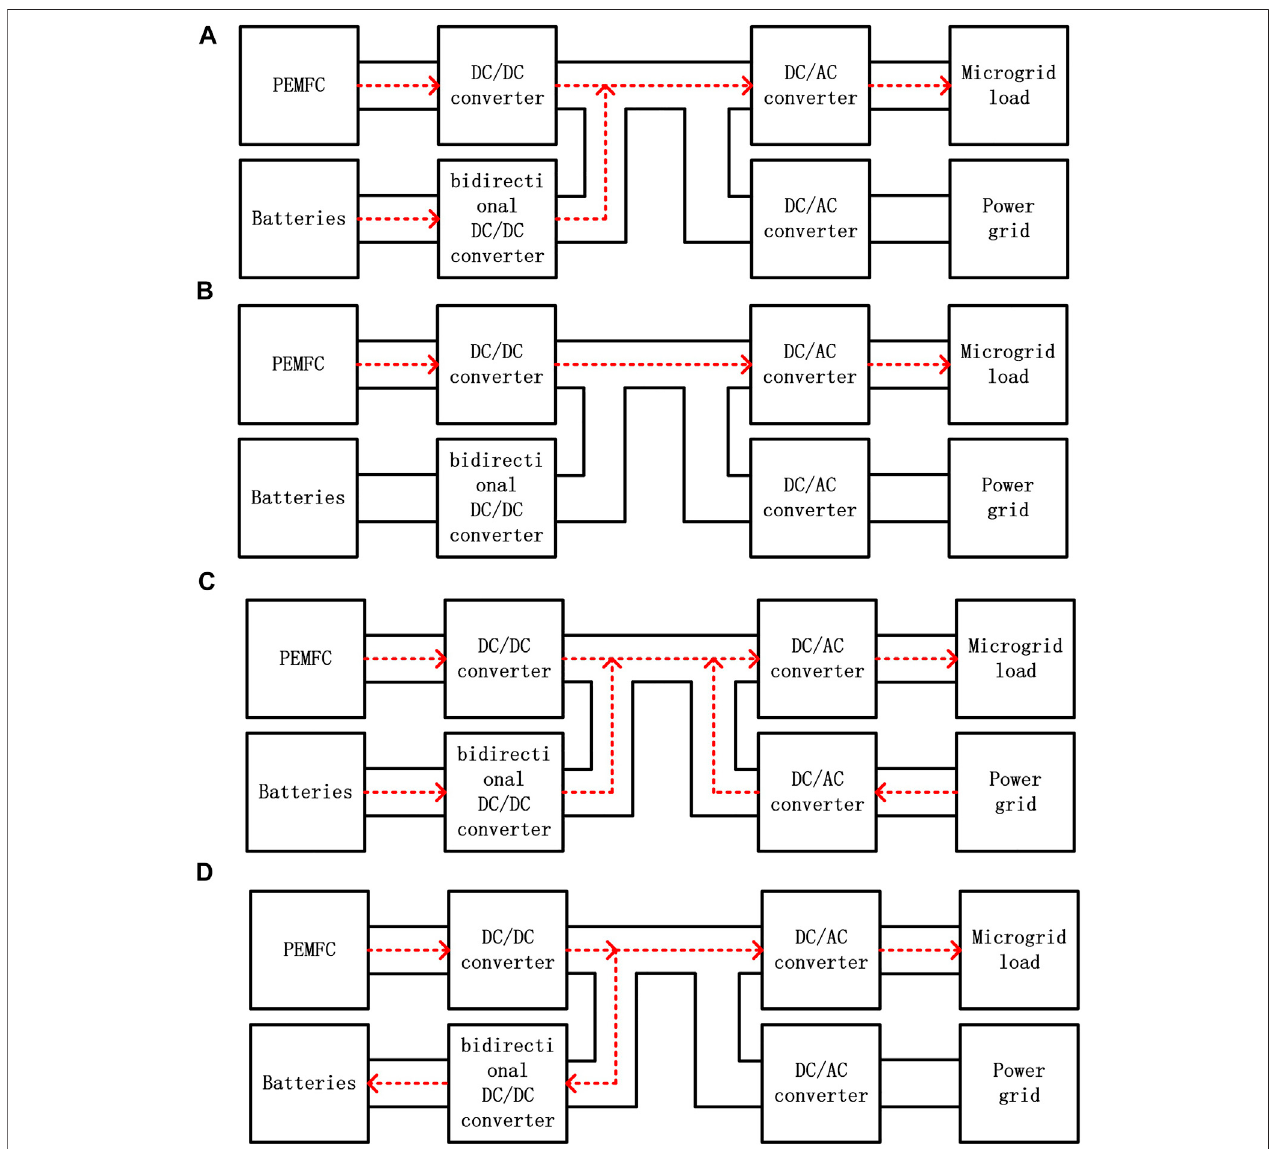
FIGURE 5 | (A) Energy fl ow diagram of mode I, (B) Energy fl ow diagram of mode II, (C) Energy fl ow diagram of mode III, (D) Energy fl ow diagram of mode